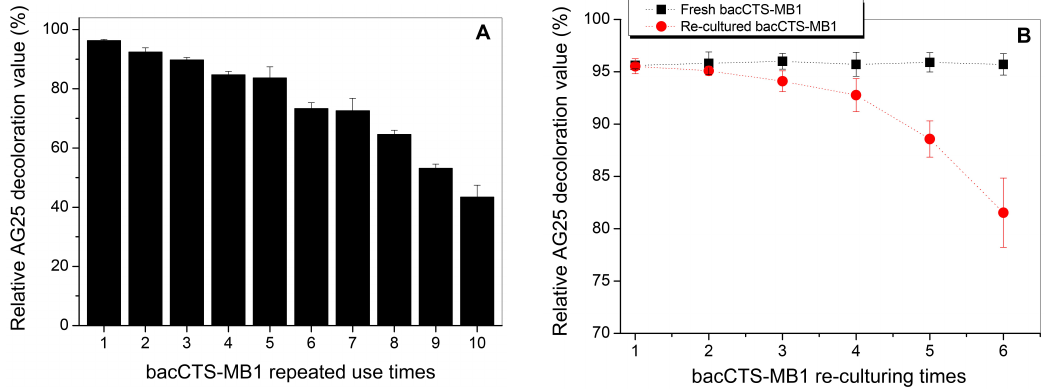
Figure 7. AG25 decolorization capacity of the bacCTS-MB1s during continuously repeated reactions ( A ) and during continuous decolorization and re-culturing cycles ( B ). In ( B ), equivalent freshly prepared bacCTS-MB1s were used as a control for each decolorization reaction cycle.